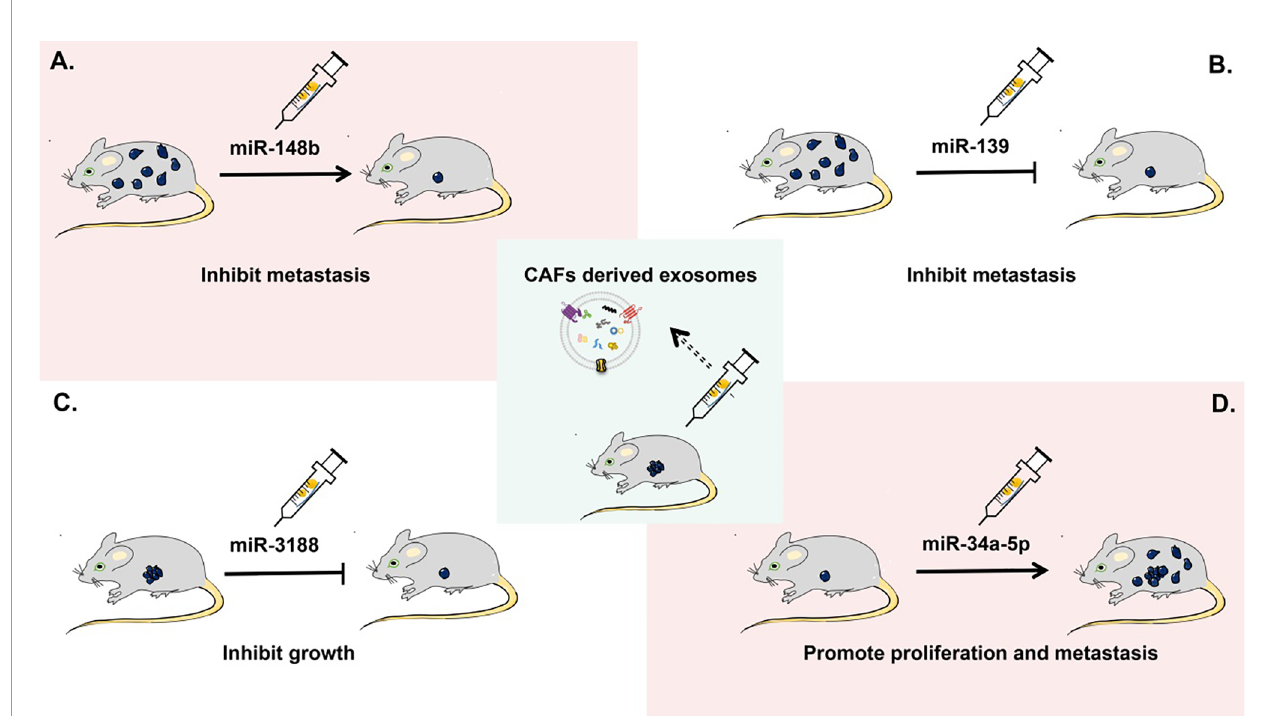
FIGURE 4 | Applications of CAF-derived exosomes as therapeutic targets in cancer in vivo . In a mouse xenograft model, (A) CAF-derived exosomal miR-148b can inhibit the metastasis of endometrial cancer cells. (B) CAF-derived exosomal miR-139 can suppress the metastasis of gastric cancer cells. (C) CAF-derived exosomal miR-3188 is able to slow down the growth of head and neck squamous cell carcinoma cells. (D) CAF-derived exosomal miR-34a-5p can promote the proliferation and metastasis of oral squamous cell carcinoma